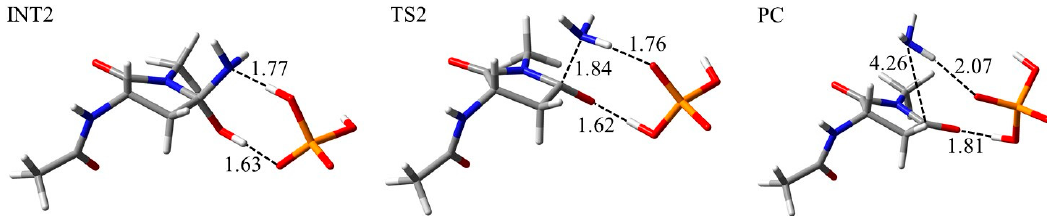
Figure 9. Optimized geometries of the deammoniation step for the syn conformation in phosphate-catalyzed reaction. The carbon, nitrogen, oxygen, and phosphorus atoms are illustrated in gray, blue, red, and orange, respectively. Selected interatomic distances are in units of Å.